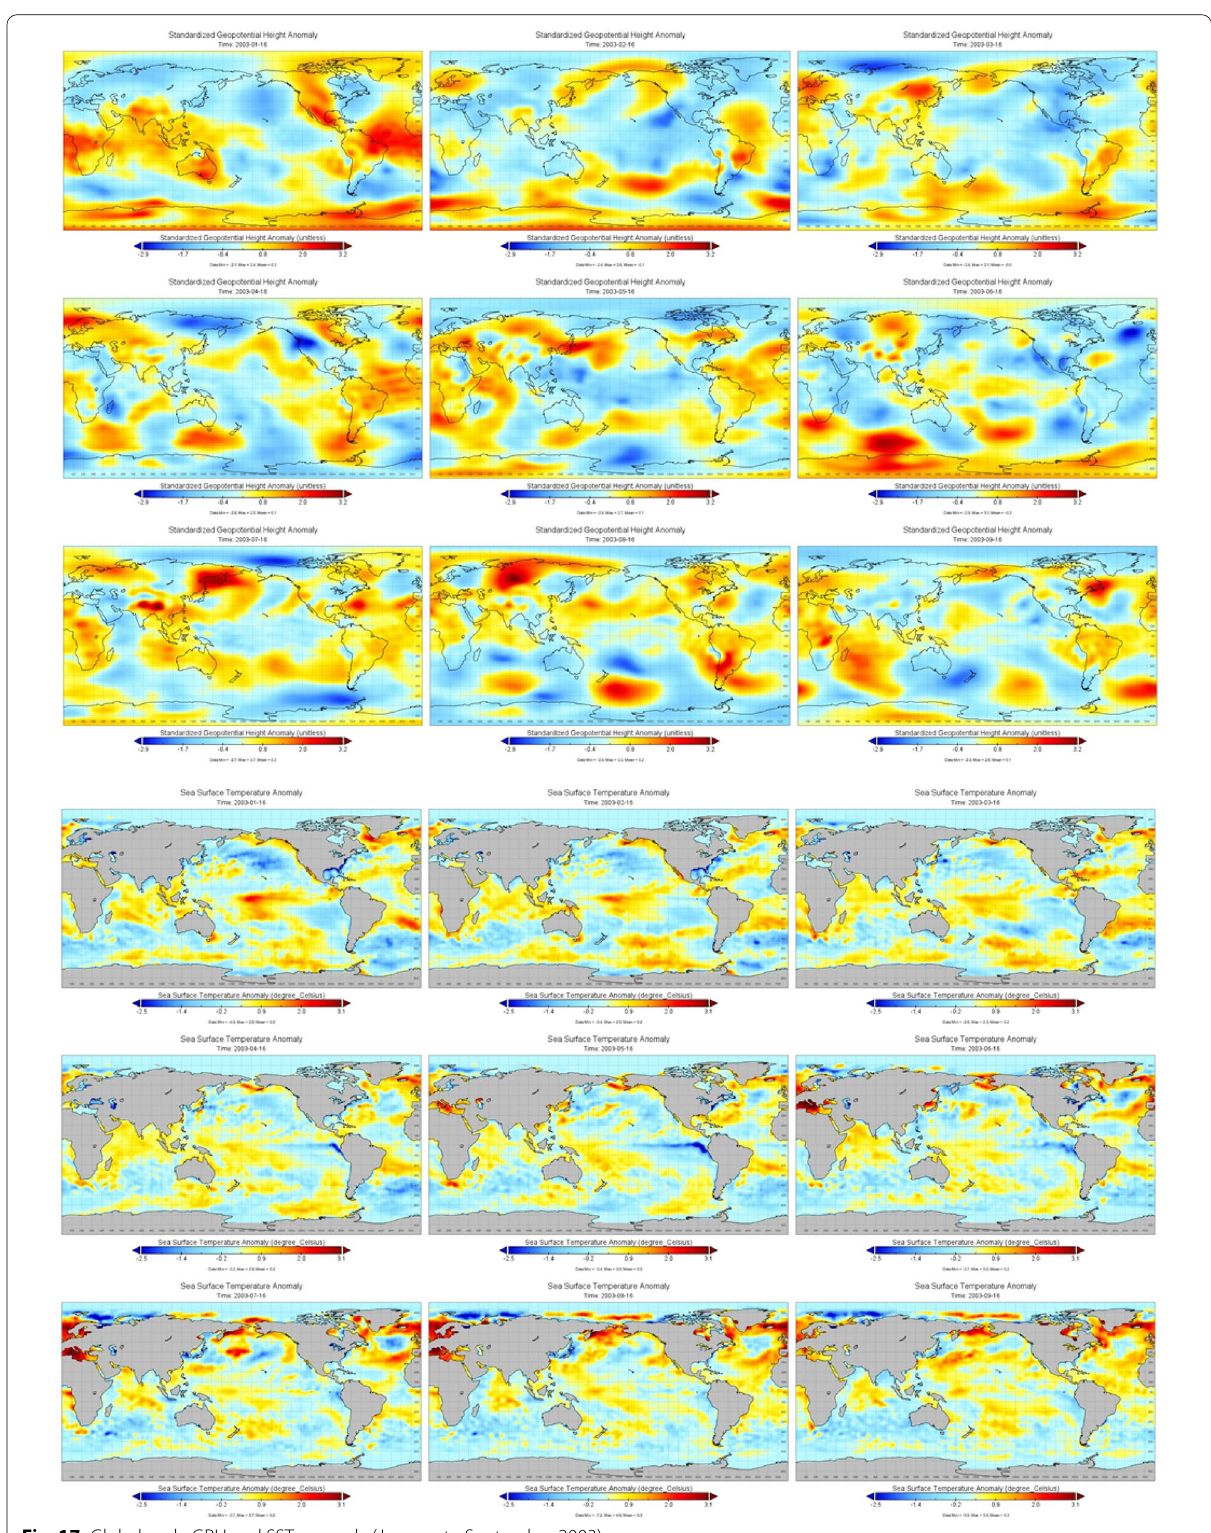
Fig. 17 Global-scale GPH and SST anomaly (January to September